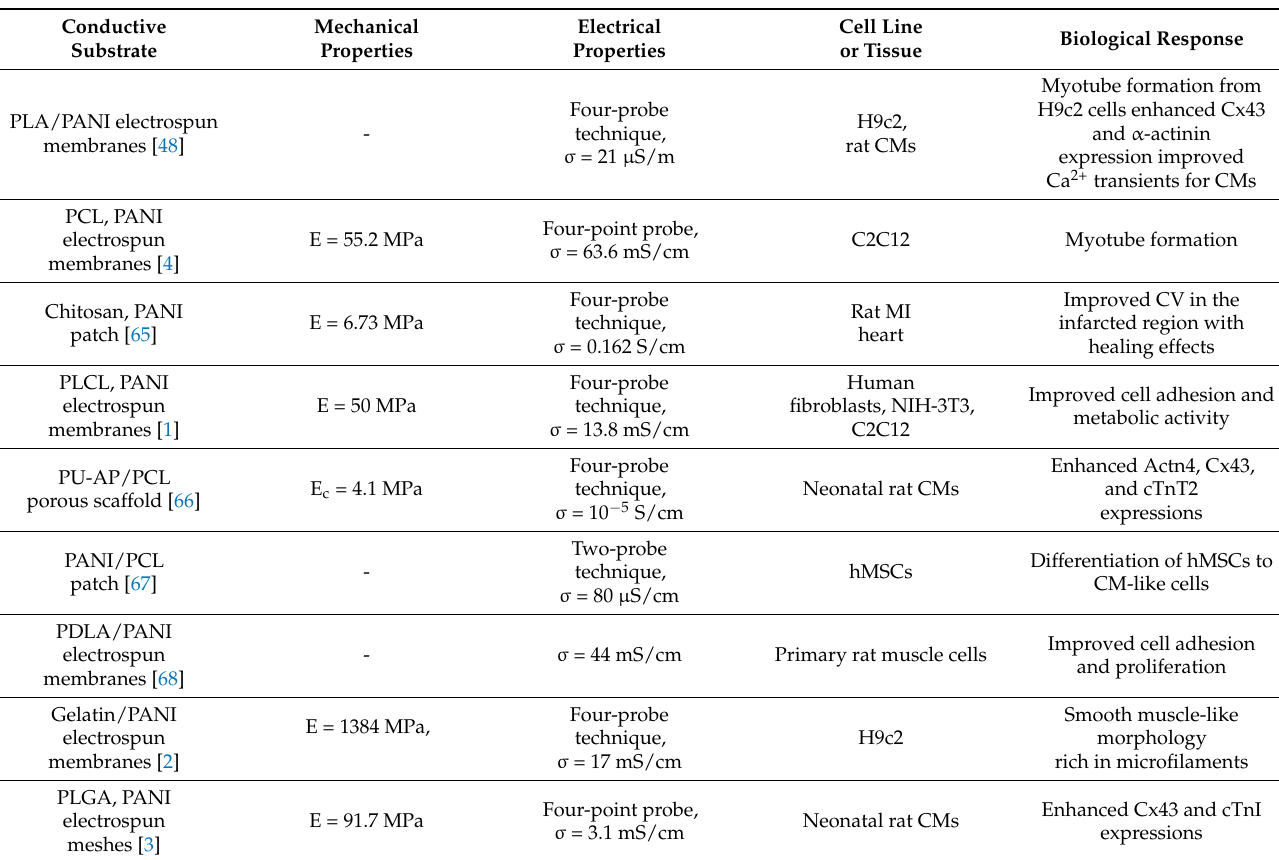
Table 1. Polyaniline-based conductive constructs for tissue